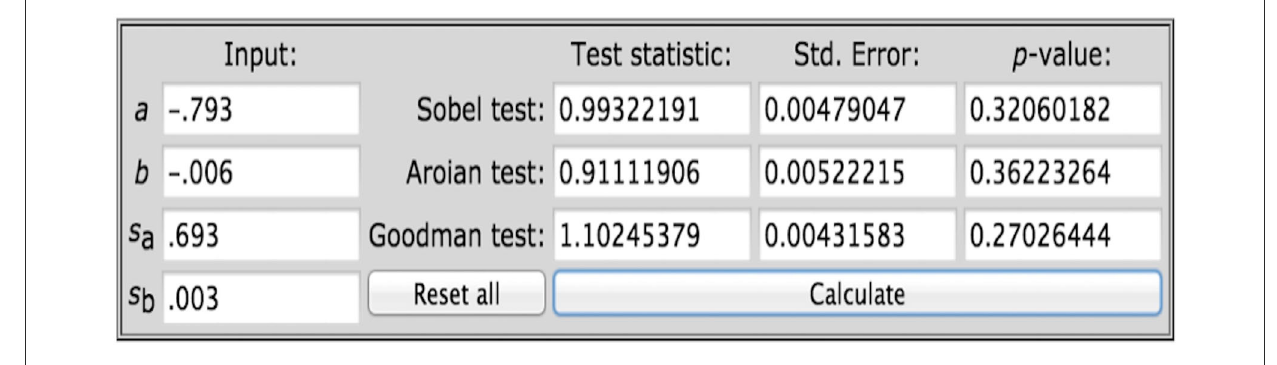
FIGURE2 Sobel test to examine